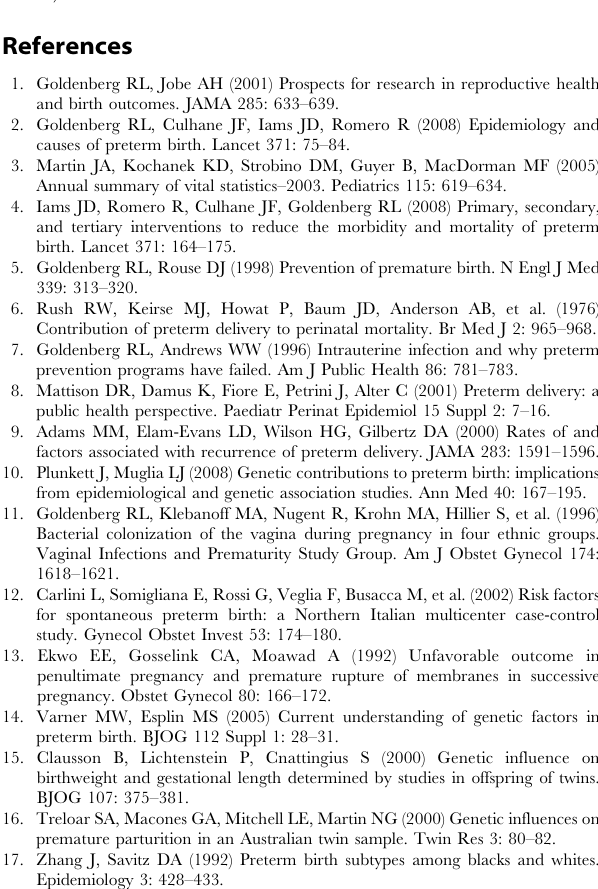
Figure S1 Maternal CRHBP Cases Found at: doi:10.1371/journal.pone.0003283.s004 (0.03 MB DOC) Figure S2 Maternal CRHBP Controls Found at: doi:10.1371/journal.pone.0003283.s005 (0.03 MB DOC) Figure S3 Maternal IL-5 Cases Found at: doi:10.1371/journal.pone.0003283.s006 (0.03 MB DOC) Figure S4 Maternal IL-5 Controls Found at: doi:10.1371/journal.pone.0003283.s007 (0.03 MB DOC) Figure S5 Maternal tPA Cases Found at: doi:10.1371/journal.pone.0003283.s008 (0.03 MB DOC) Figure S6 Maternal tPA controls Found at: doi:10.1371/journal.pone.0003283.s009 (0.03 MB DOC) Figure S7 Maternal FV Cases Found at: doi:10.1371/journal.pone.0003283.s010 (0.08 MB Figure S8 Maternal FV Controls Found at: doi:10.1371/journal.pone.0003283.s011 (0.08 MB Figure S9 Maternal PTGER3 Cases Found at: doi:10.1371/journal.pone.0003283.s012 (0.24 MB